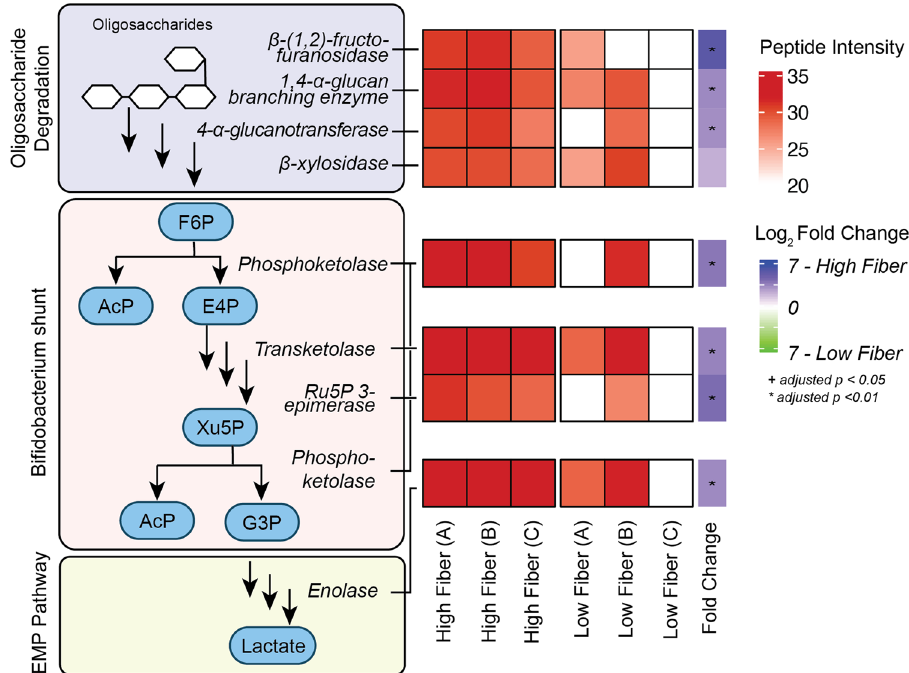
Fig. 3 ABPP identi fi es Bi fi dobacterium enzymes involved in carbon catabolism with increased activity under HF conditions. Of the eight bi fi dobacterial enzymes, seven were signi fi cantly enriched ( q value < 0.05) under HF conditions. Steps of the pathway are shown to the left and a heatmap of protein intensity is shown on the right. The log 2 -transformed sum of unique peptide intensities for proteins is shown in red, while white cells indicate the protein was not detected in that sample group. Imputed log 2 fold change is shown on the right where blue indicates proteins enriched in HF conditions and green indicates proteins enriched under LF conditions.